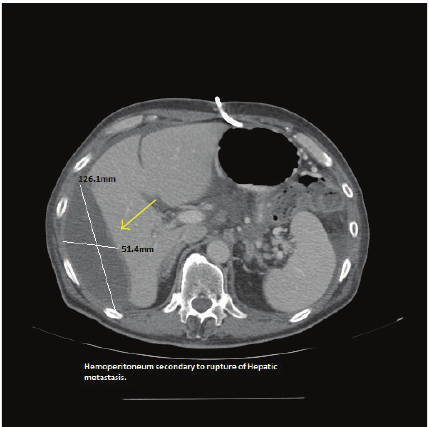
Figure 3: Axial contrast enhanced CT image (same study as in Figure 1) showing (yellow arrow) subcapsular liver collection.